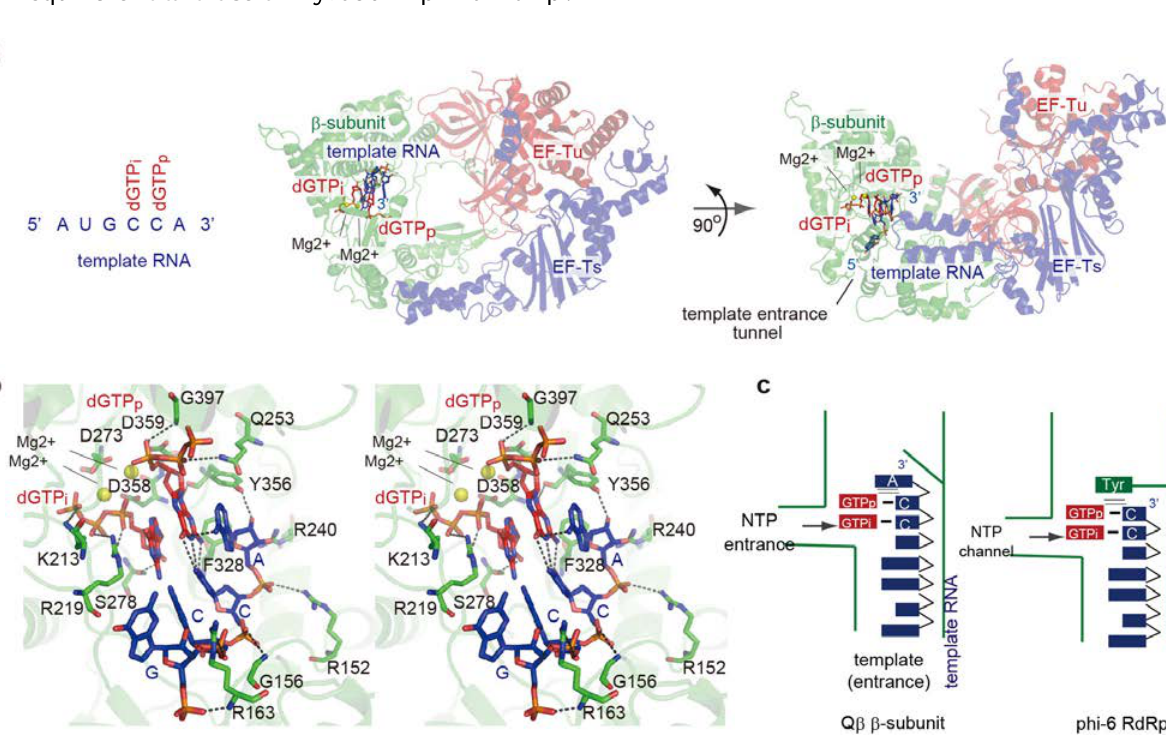
Figure 3. Structure of the de novo initiation stage. ( a ) Overall structure of the initiation stage of RNA polymerization. The sequence of a template RNA with CCA-3' is depicted. The β-subunit, EF-Tu and EF-Ts are colored green, red, and blue, respectively; ( b ) Detailed view of the catalytic pocket at the initiation stage. The template RNA and GTP analogs (dGTPp) and (dGTPi) are depicted by stick models; ( c ) Simplified depiction of the structure representing the de novo initiation of RNA polymerization by the core Qβ replicase ( left ), and its comparison with the structure representing the de novo initiation of RNA polymerization by phi-6 RdRp ( right ). The functions of the 3'-A in Qβ RNA would be equivalent to those of Tyr630 in phi-6